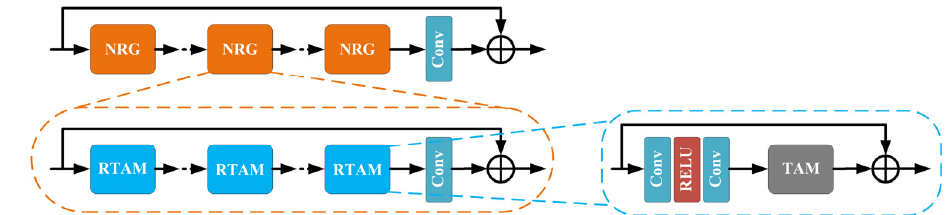
Figure 2. The framework of the proposed multiple nested residual group (MNRG) structure.